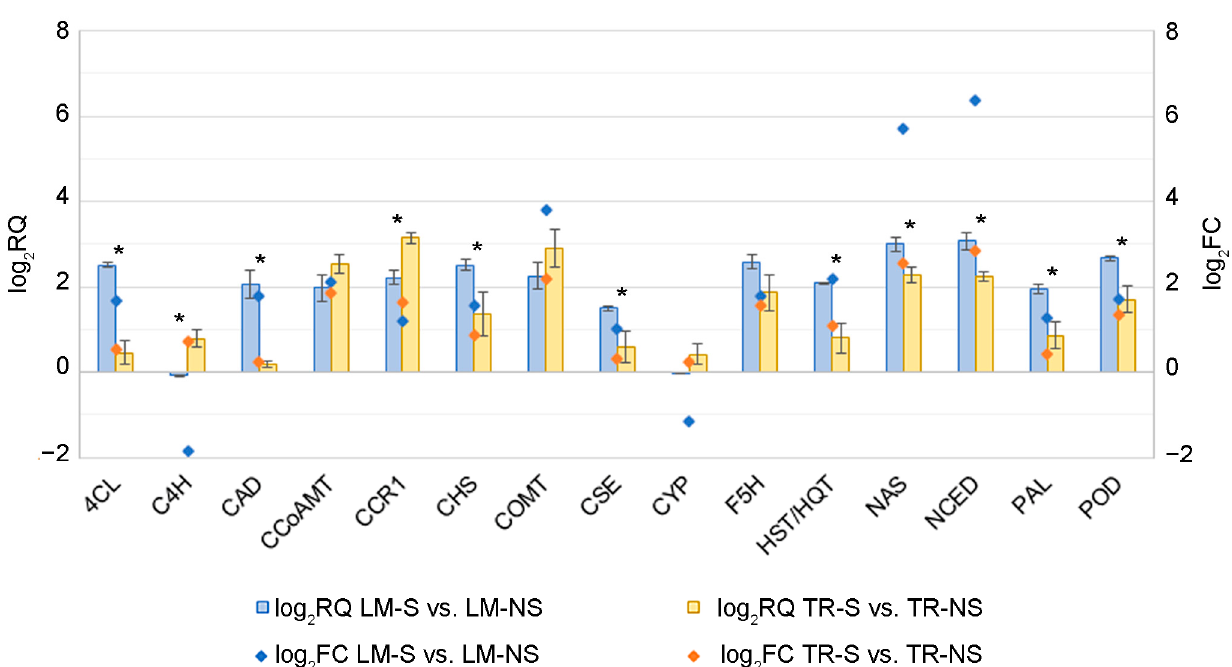
Figure 6. Validation of RNAseq data by quantitative real-time PCR (qPCR) of genes involved in the biosynthesis of secondary metabolites in sanitized (S) vs. non-sanitized (NS) plants of Locale di Mola (LM) and Troianella (TR). Columns represent log 2 of gene expression value (RQ) obtained from qPCR calculated as the mean of three biological replicates. The NS condition was used as a reference plant for gene expression normalization, as a non-treated plant ecotype. Elongation factor 1 alpha ( EF-1a ) was used as a housekeeping gene for target gene normalization. For each gene, asterisks (*) indicate log 2 RQ values with statistically significant differences for p ≤ 0.05 performing a Tukey post hoc ANOVA test. Square points represent log 2 of FC obtained from DESeq2 analysis. Gene abbrevi-